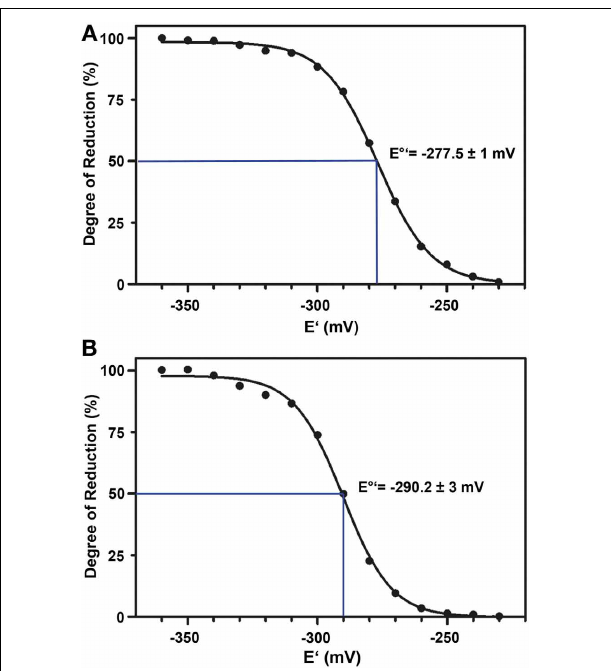
FIGURE 5 | Redox titration of roGFP2 and GRX1-roGFP2. The degree of reduction of roGFP2 (A) and GRX1-roGFP2 (B) was determined from the excitation ratios plotted against the potential of the ambient redox buffer. Representative measurements of at least 3 independent redox titrations (with 4 replicates each) for both probes are shown.